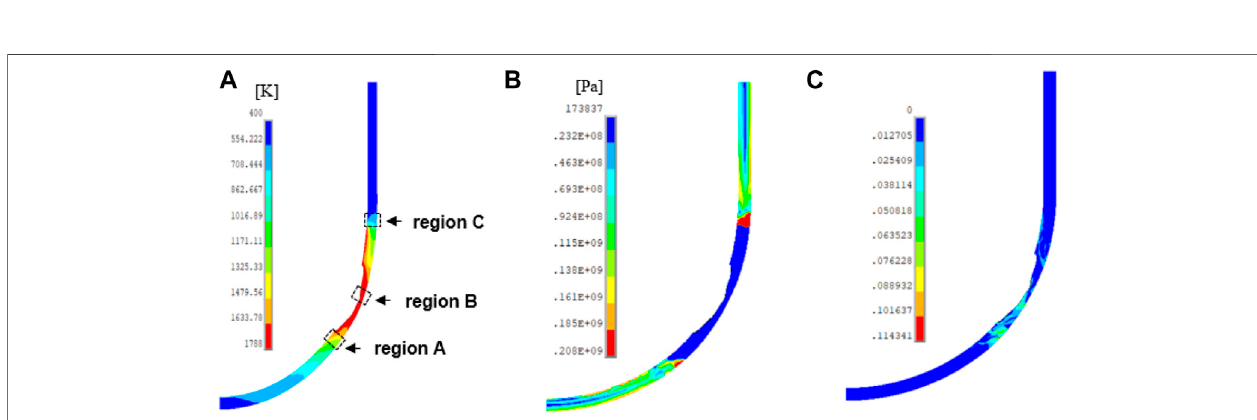
FIGURE8| ThicknessoftheRPVlowerheadat t =6.17 h, t =6.50 h, t =6.83 h, t =7.17 h,and t =7.22h/7.33 h(thetimeofmelt-through)for (A) SBOand (B) SBO + LOCA cases.